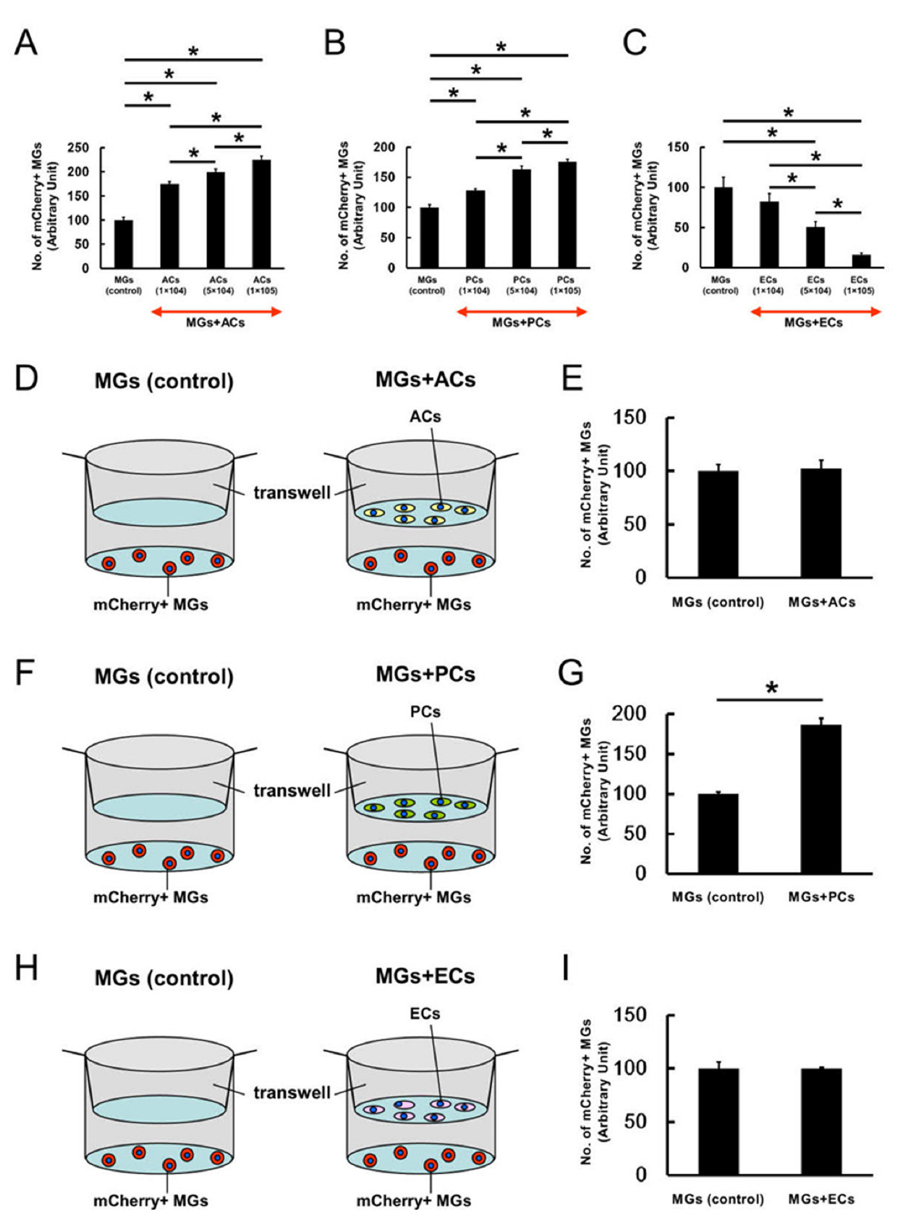
Figure 5. Whether ACs, PCs, or ECs affected microglial numbers dose-dependently was investigated under direct cell–cell contact conditions ( A – C ). The number of mCherry + MGs significantly increased dose-dependently after coincubation with ACs ( A ) and PCs ( B ), but it was significantly decreased dose-dependently after coincubation with ECs ( C ). The same number of mCherry + MGs and ACs ( D ), PCs ( F ), or ECs ( H ) were incubated under conditions that did not allow direct cell contacts. Compared with the control (mCherry + MGs alone), ACs ( E ) and ECs ( I ) did not alter the number of mCherry + MGs, while PCs significantly increased it ( G ). Statistical analysis was per- formed using a one-way ANOVA, followed by Bonferroni post-hoc tests (( A – C ); n = 4 for each group) or the Student’s t -test (( E , G , I ); n = 4 for each group). * p < 0.05 among the groups ( A , B , C ). * p < 0.05 between MGs alone (control) ( G ). Abbreviations: AC, astrocyte; EC, endothelial cell; MG, microglial cell; PC, pericyte.